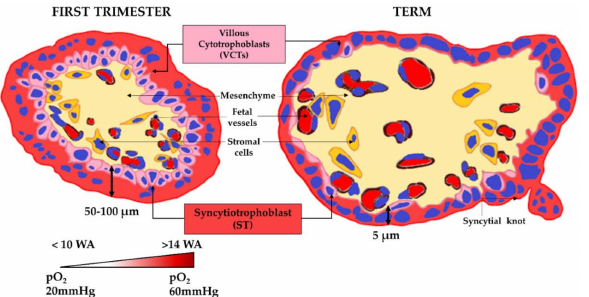
Figure 1. Diagram of a cross-section of a villus in the first trimester of pregnancy and at term. The pla- cental barrier is made of syncytiotrophoblast (ST) and villous cytotrophoblast (VCT). The thickness of this barrier decreases during pregnancy from 50–100 µ m at the first trimester to 5 µ m at term. The constant renewal of the ST occurs by fusion with the VCTs and the release of syncytial knots. In the center of the chorionic villus, the fetal vessels are surrounded by mesenchyma and stromal cells. The oxygen pressure in the intervillous chamber varies during the first trimester from 20 mmHg (2–3% O 2 ) before 10 WA to 60 mmHg (6–8% O 2 ) above 14